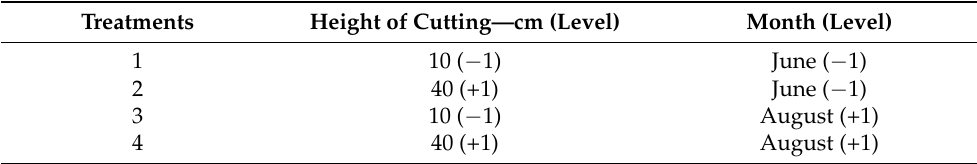
Table 1. Treatments adopted for revitalization of yerba-mate crop. Treatments